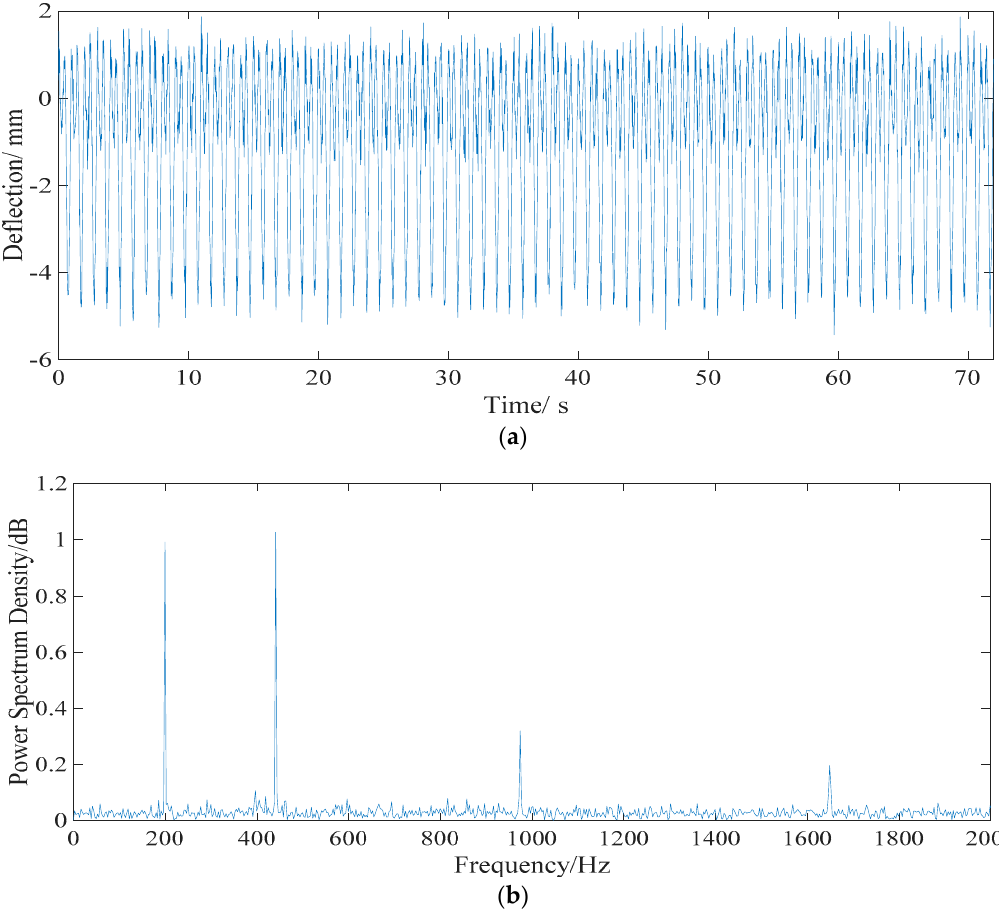
Figure 6 . Time history and frequency spectrum of live load deflection. ( a ) Time history data. ( b ) Frequency spectrum.